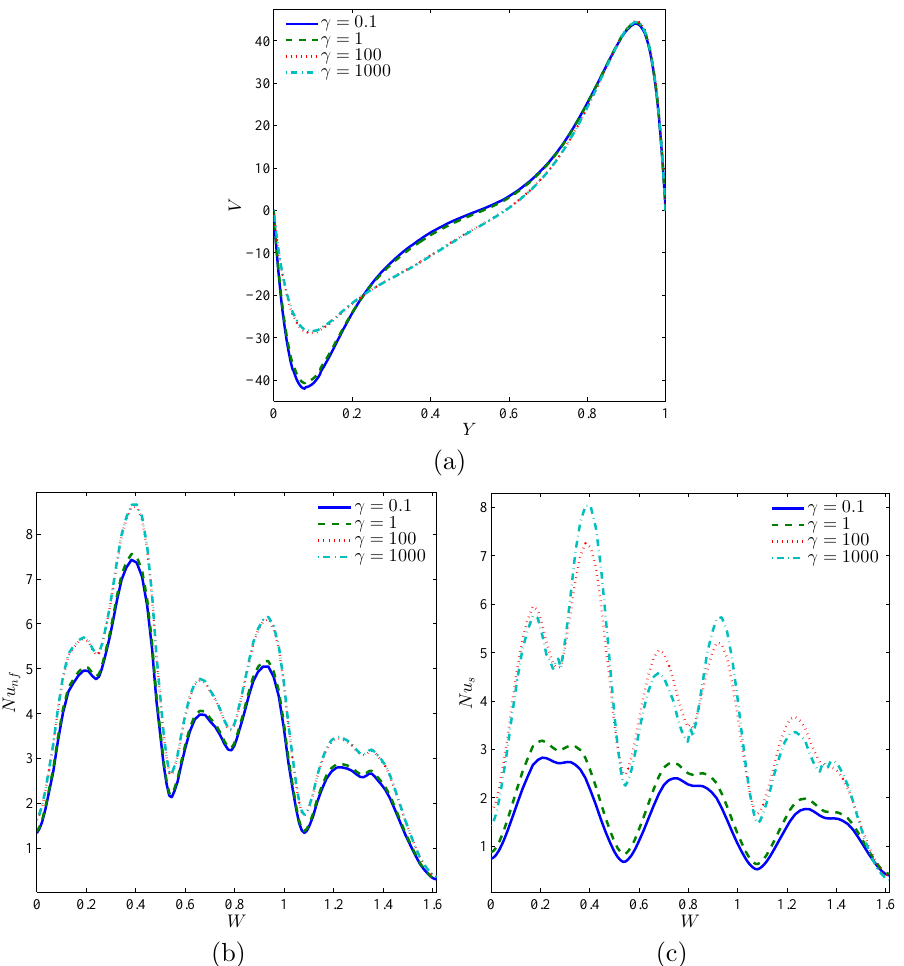
Figure 8. Local velocity ( a ), the local Nusselt number of the nanofluid phase ( b ), and the local Nusselt number of the solid phase ( c ) with the vertical line ( Y ) for X = 0.5 for Y = 0.5 for different γ values; Da = 10 − 3 , φ = 0.02, A = 0.1, and ε =